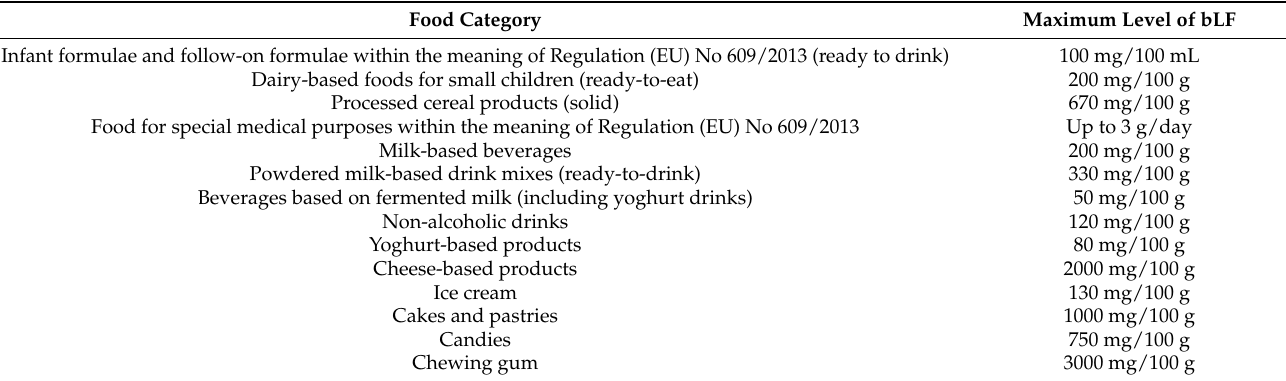
Table 6. Use of bLF in food products